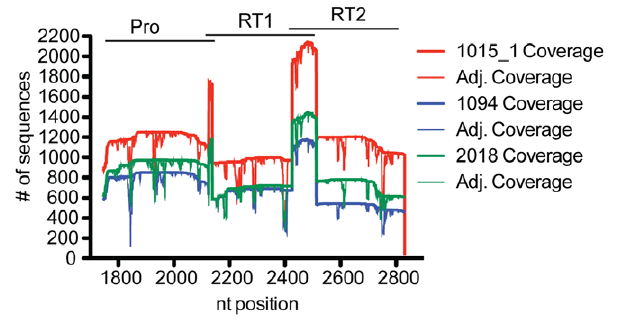
Figure 3. Sequence coverage and adjusted sequence coverage of three representative patient samples. The number of sequences representing each nucleotide position (coverage) from three patient samples sequenced in the same GS Junior run is shown after alignment to the NC_001802 HXB2 HIV reference sequence. Also shown is the number of sequences that align to each nucleotide position after eliminating sequences with low quality scores (adjusted coverage) at each nucleotide position for each patient sample. Pyrosequencing was performed on three overlapping amplicons with nucleotide positions for each amplicon represented at the top of the graph.